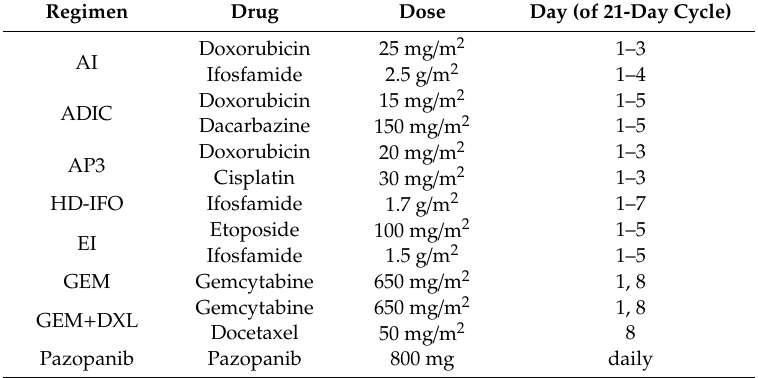
Table A2. Chemotherapy regimens used in the 1st line depending on the year of treatment start.